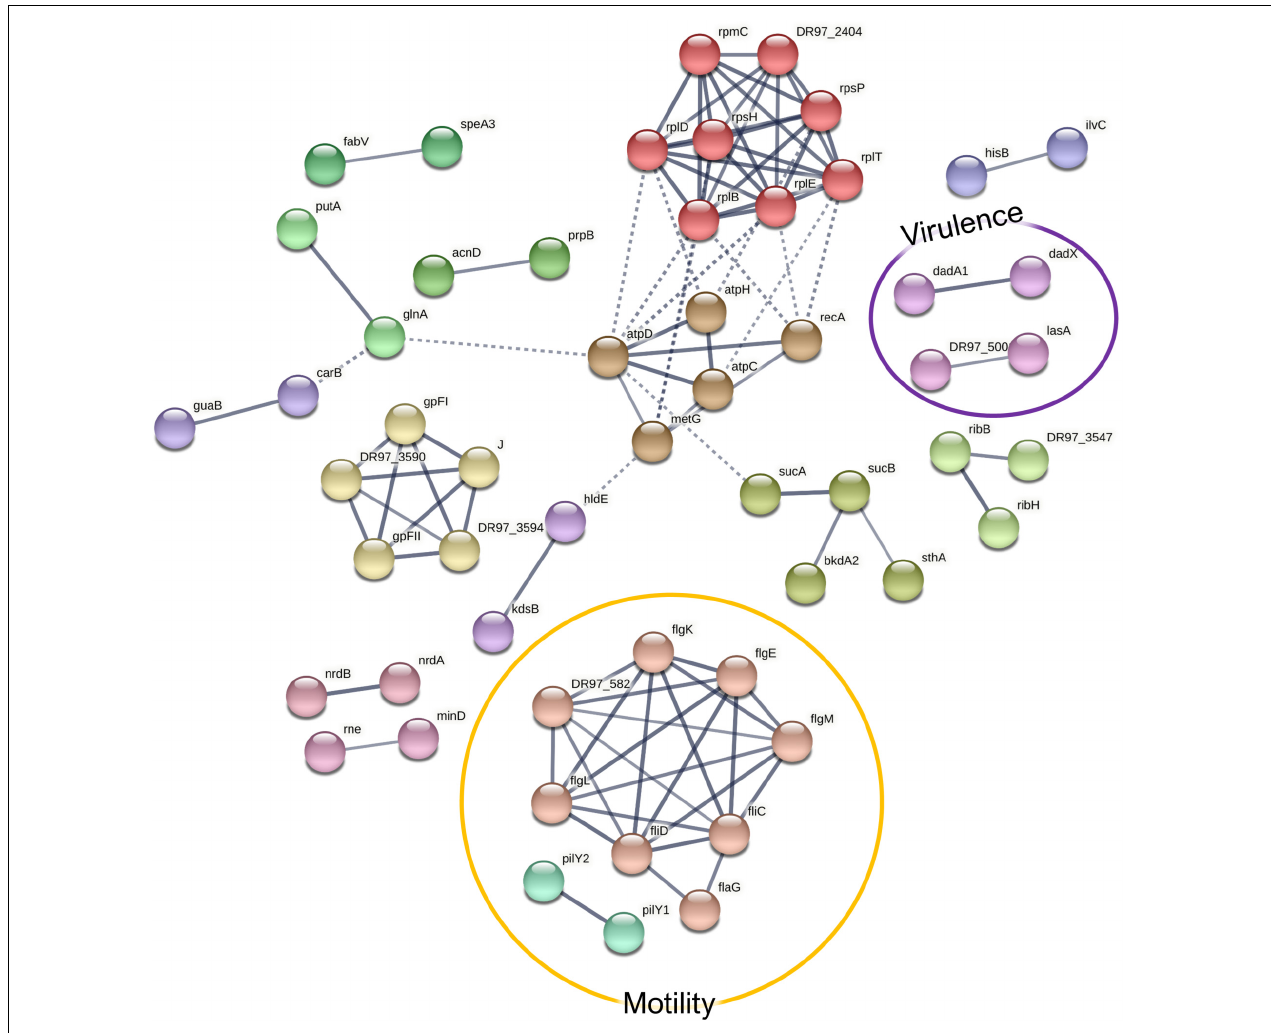
FIGURE 6 | A STRING database (Szklarczyk et al., 2019) network of interacting proteins with a significantly higher abundance in Pseudomonas aeruginosa co-culture versus monoculture exoproteome. Due to the large number of interactors, only high-confidence interactions are